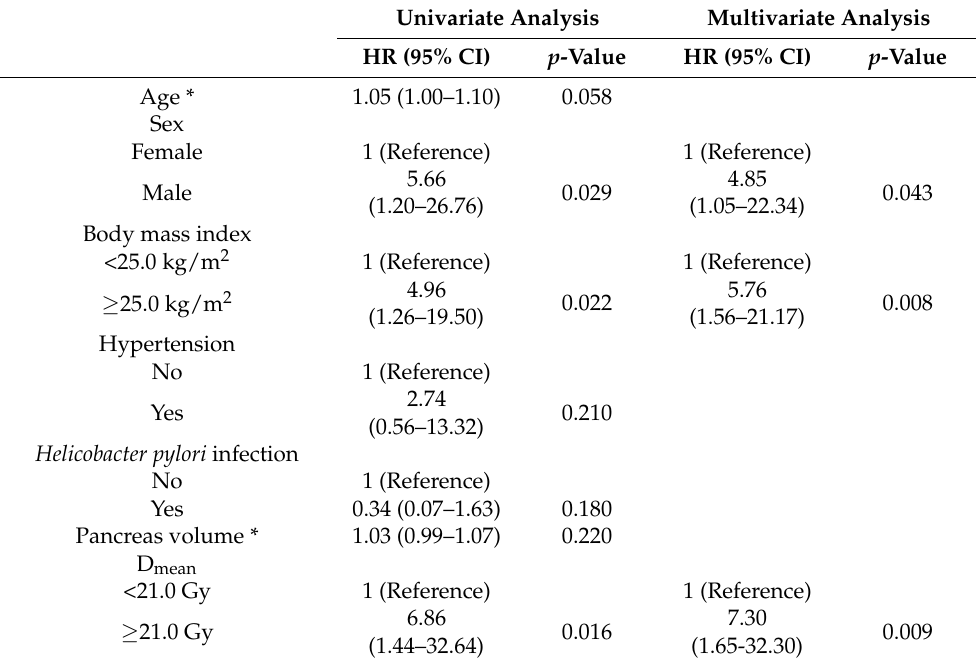
Table 4. Univariate and multivariate competing risk analyses for predicting the development of diabetes